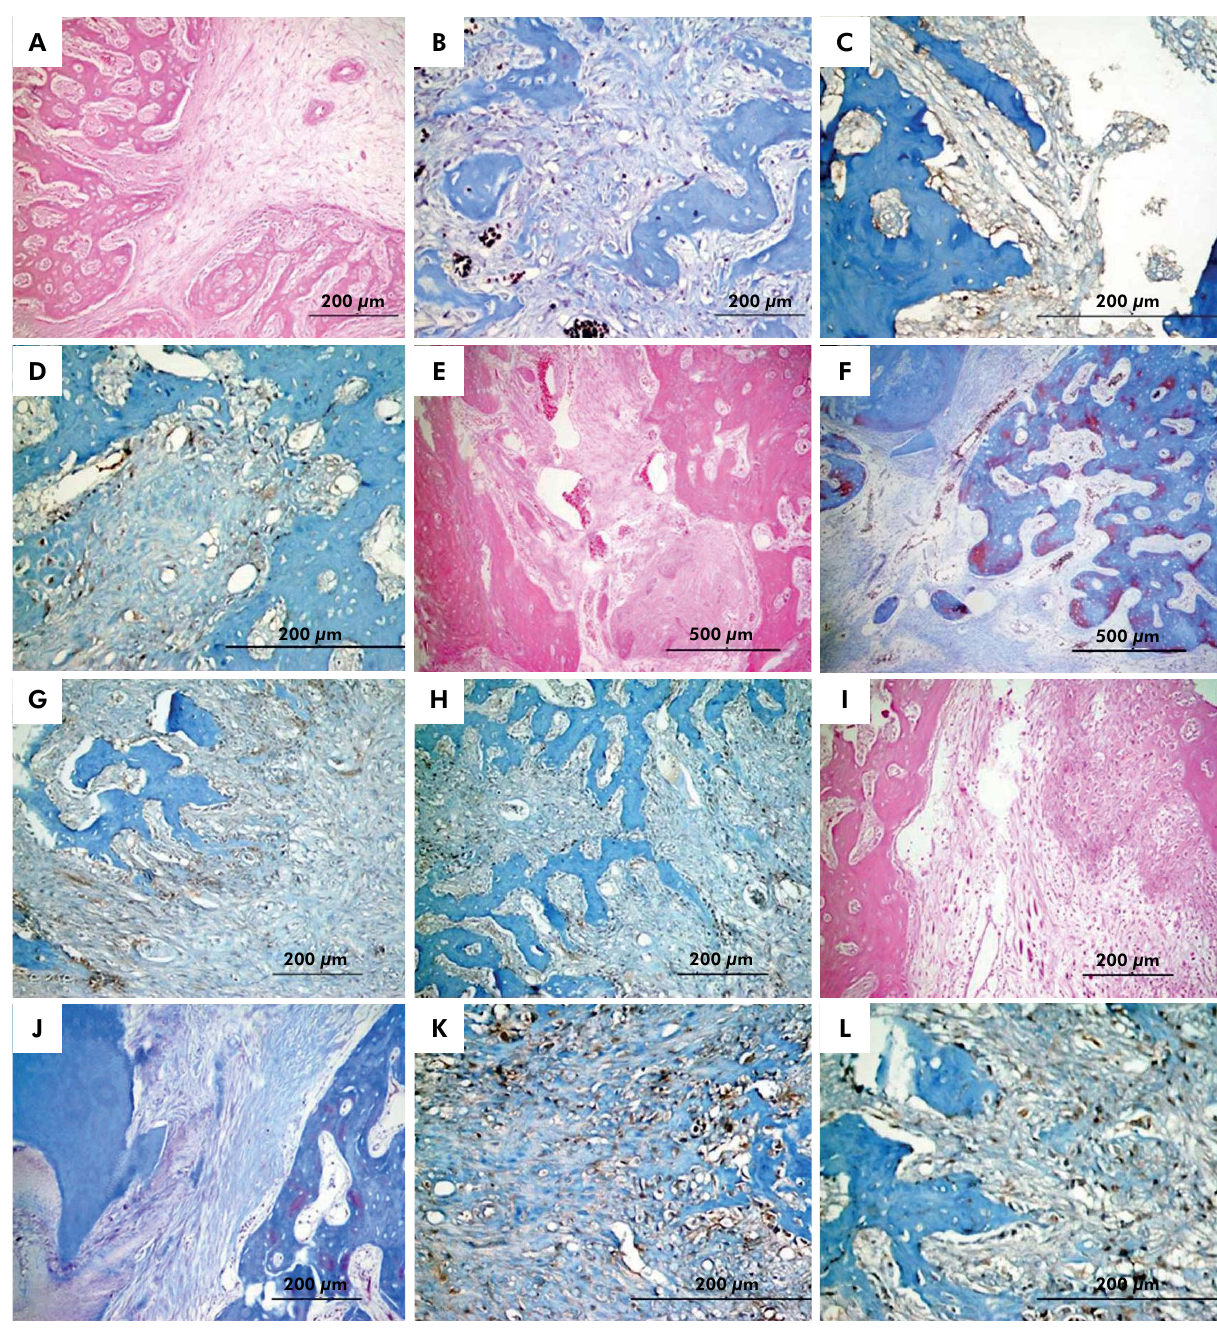
Figure 2. Histological and immunohistochemical (IHC) evaluation of the distraction regeneration. In all the groups distraction areas-between the two bone fragments area-were filled with new bone tissues. Control group: (a) HE, haematoxylin and eosin; (b) MT, Masson trichome; (c) IHC-OPN, osteopontin; (d) IHC-VEGF, vascular endothelial growth factor. Melatonin dose 1 group: (e) HE, (f) MT, (g) IHC-OPN, (h) IHC-VEGF. Melatonin dose 2 group: (i) HE, (j) MT, (k) IHC-OPN, (l)